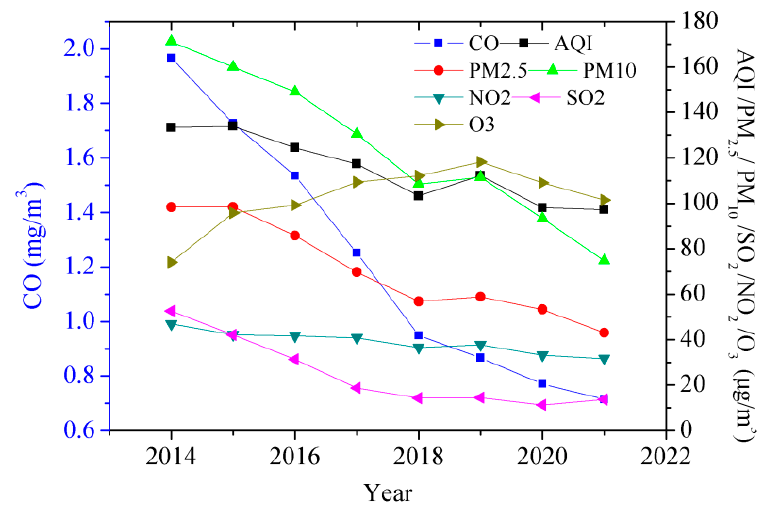
Figure 3. Annual change in air quality in Liaocheng City from 2014 to 2021.